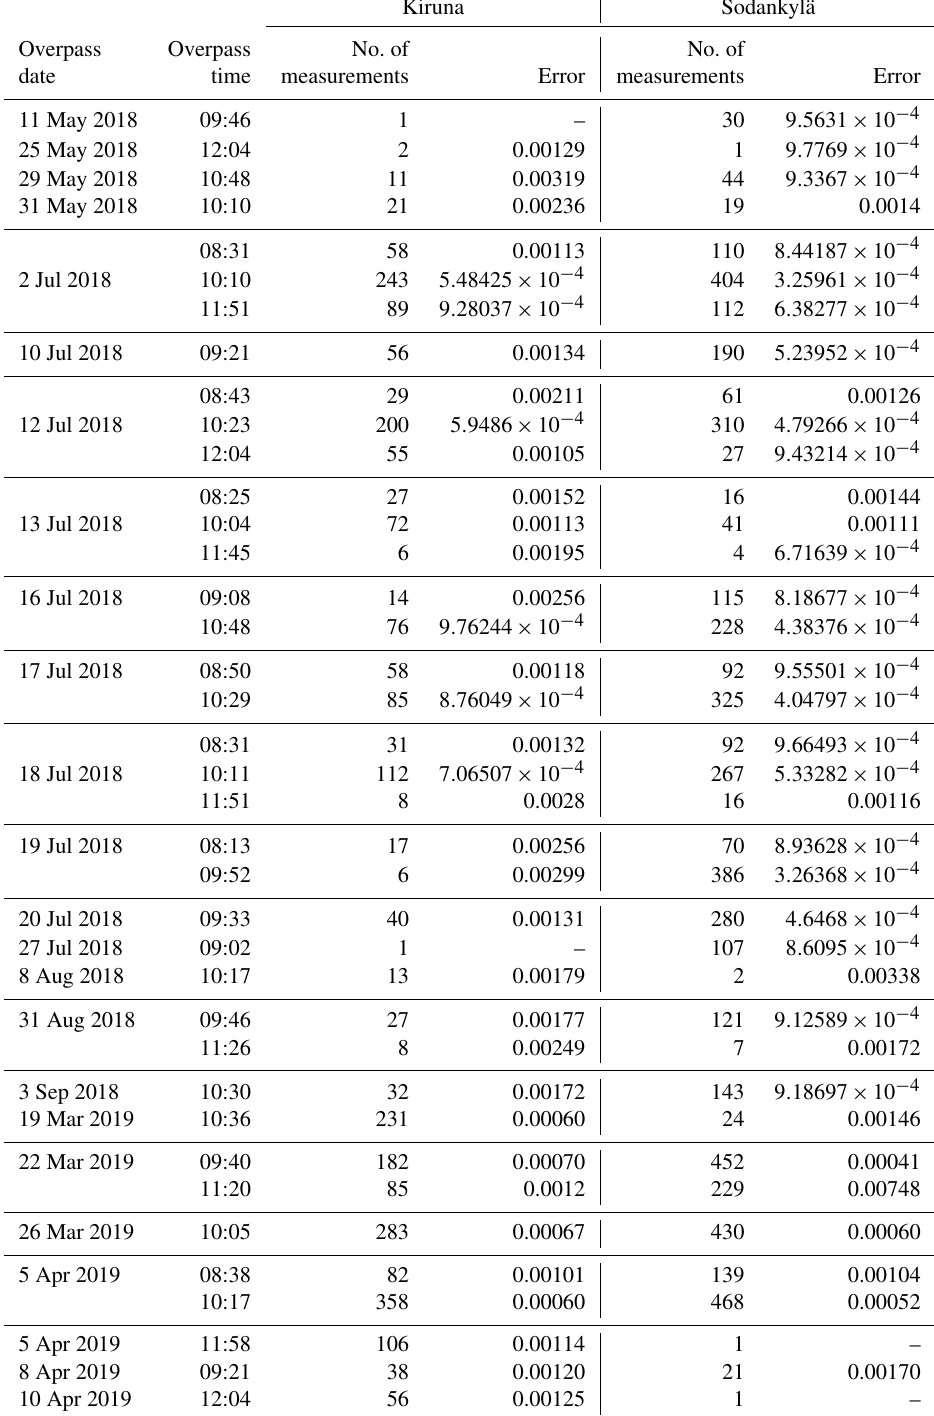
Table A1. The statistics of S5P data coincident with COCCON data when S5P overpassed both sites in 1d. The error indicates the standard error of